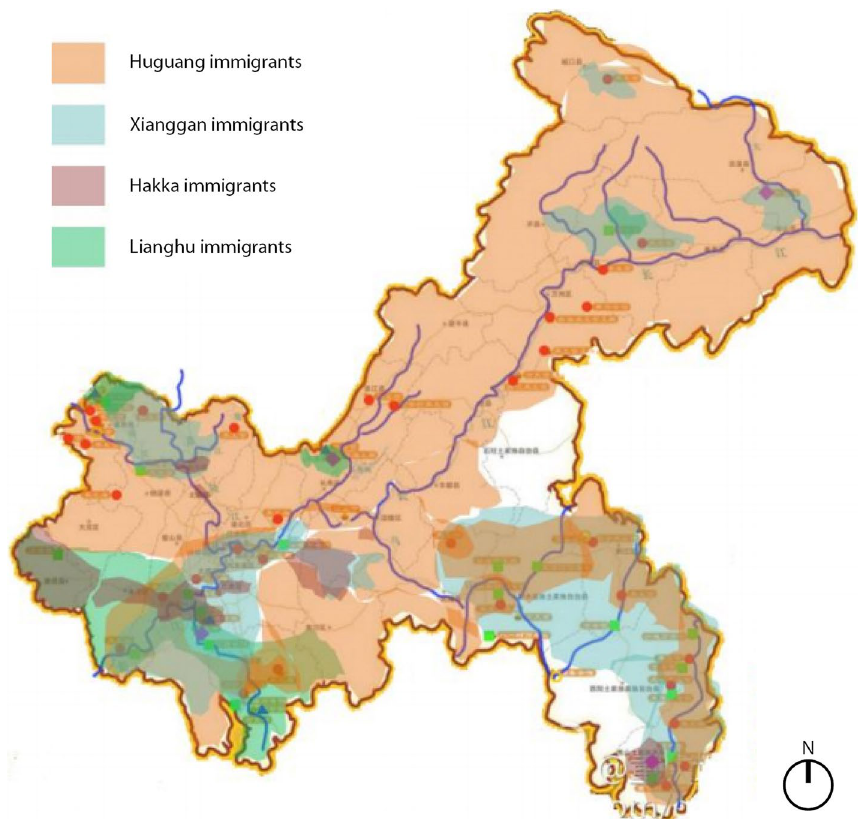
Fig. 4 Geographical distribution of ancient immigrants in Chongqing (Source: Xiaoyin Zhang, based on ‘Research on the Geographical Features of the Distribution of Sichuan Indigenous and Immigrants in Qing Dynasty’ and ‘Chongqing Immigration